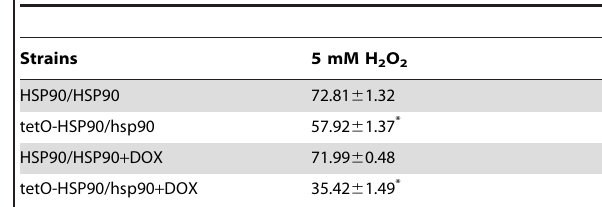
Table 4. Caspase activity of C. albicans cells after H 2 O 2 treatment 4 .